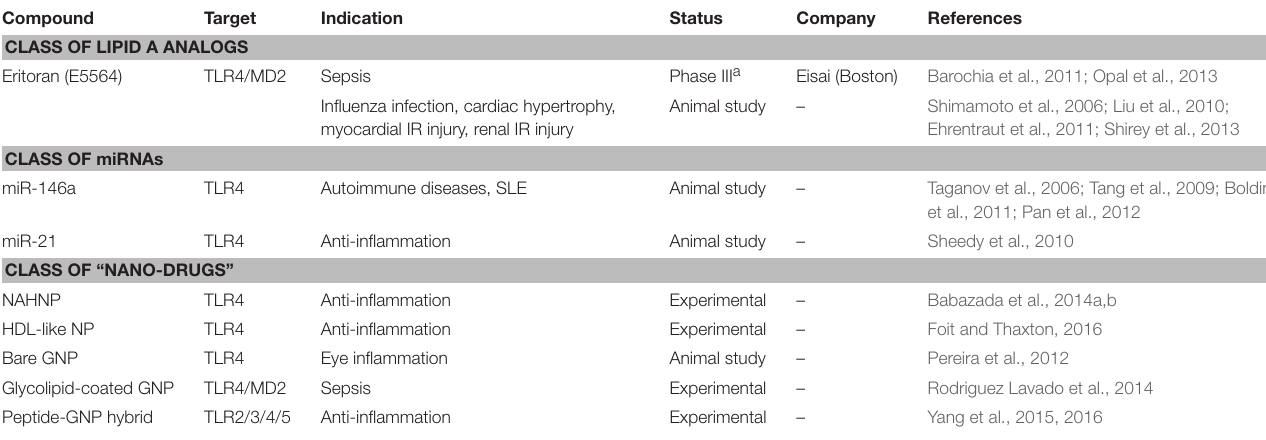
TABLE 5 | The development status of TLR antagonists/inhibitors: classes of lipid A analogs, miRNAs and “nano-drugs.”